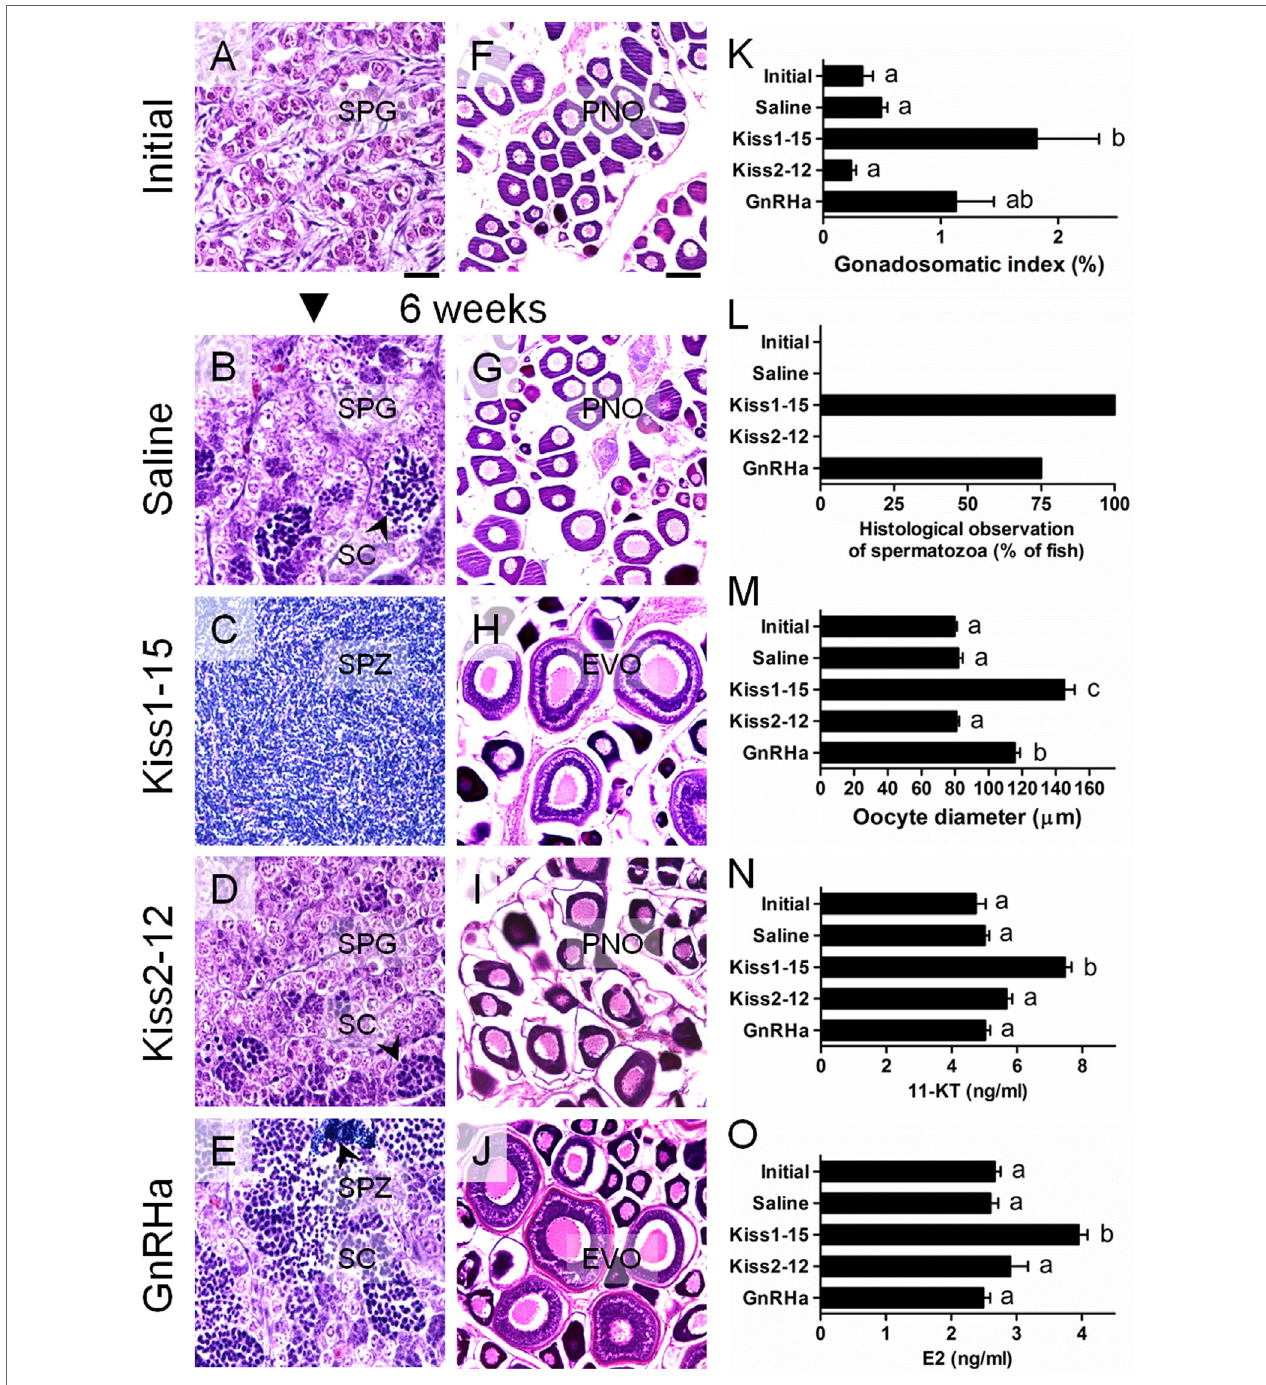
FigURe 3 | Changes in the gonadal histology of male (A–e) and female (F–J) chub mackerel in different treatments. Abbreviations; SPG, spermatogonia; SC, spermatocytes; SPZ, spermatozoa; PNO, perinucleolar oocyte; EVO, early vitellogenic oocyte. Scale bars = 100 µm. (K) Changes in the gonadosomatic index (GSI) of male fish. (L) Percentage of fish by treatment showing histological presence of SPZ in the testes. (M) Changes the mean oocyte diameter of fish at different treatments, respectively. Changes in serum 11-ketotestosterone (11-KT) in male (N) and estradiol-17b (E2) in female (O) , respectively. Values are means ± SEM ( n = 4–6 for each treatment). Different letters above the bars represent significant differences between treatments ( p < 0.05, one-way ANOVA followed by a Tukey’s multiple comparison test). GnRHa: GnRH analog (D-Ala 6 , des-Gly 10 )-LHRH ethylamide. Modified from Ref. (50), by permission of Zoological Society of